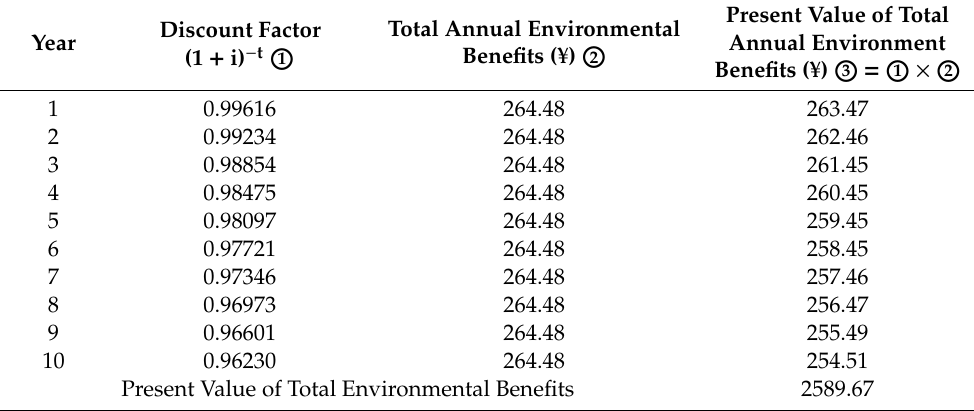
Table 8. Present value of the total environmental benefits of using a solar water heater.